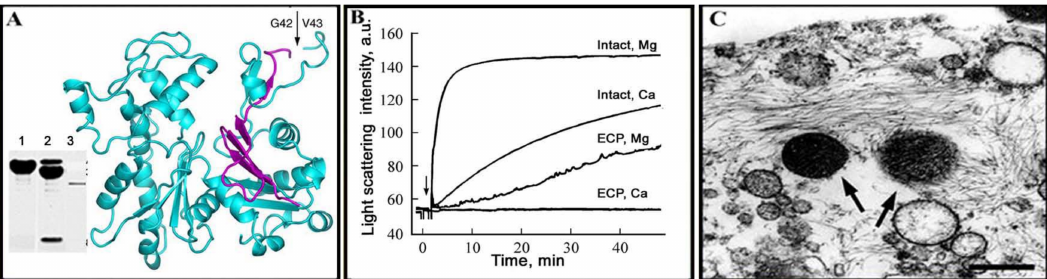
Figure 1. The actinase activity of grimelysin (ECP 32). ( A ) Three-dimensional structure of skeletal muscle actin cleaved with grimelysin (ECP 32) at a single site, Gly42-Val43, within the DNase I-binding loop [35]. Inset shows SDS electrophoresis of actin (lane 1), with the actin 36 and 8 kDa fragments produced by the grimelysin (ECP32) cleavage; the upper band is actin not completely cleaved in this experiment (lane 2) and isolated grimelysin (ECP 32) (lane 3) [8,10]. ( B ) Polymerization of ECP-cleaved skeletal muscle actin compared to that of intact actin. ( C ) Invasion of human larynx carcinoma Hep-2 cells by Serratia grimesii 30063. Intracellular bacteria are marked with arrows. Scale bar, 1 µ m. Arrows indicate intracellular bacteria Reproduced from [13,21,35] with permissions from Elsevier Licences 4820990651384 and 1032953-1, 2020 ( A , B ) and from Wiley Licence 4821290007049, 2020 ( C